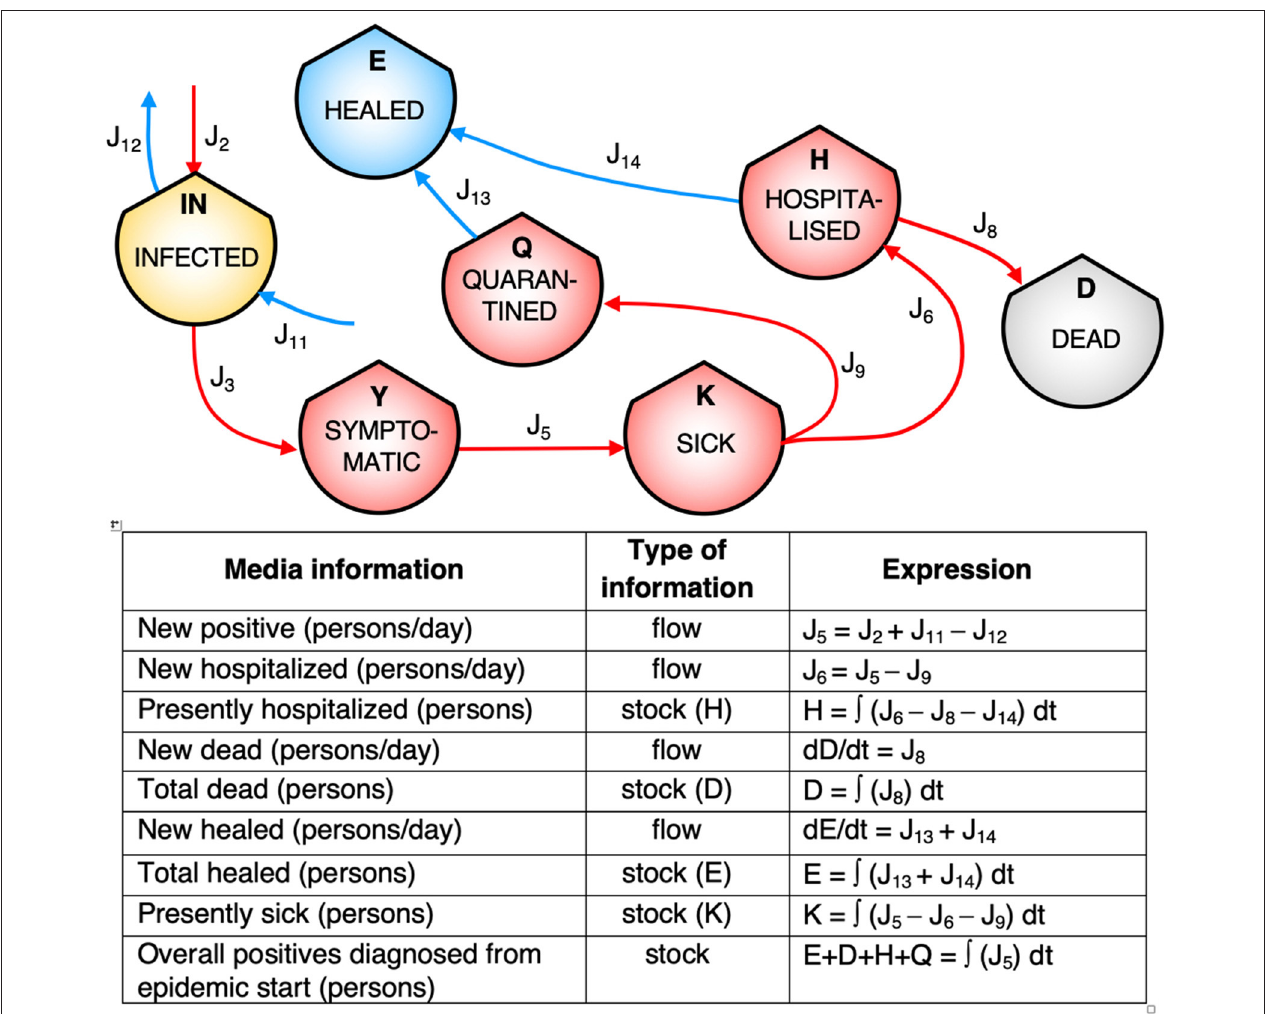
FIGURE 2 | Simplified version of the diagram, keeping only people stocks and the corresponding flows. The figure visualizes the actual information typically given day by day by the media in terms of stocks and flows, as reported in the legend within the figure (J 9 may be assumed to be equal to J 13 ). The mathematical espressions of the elements are also